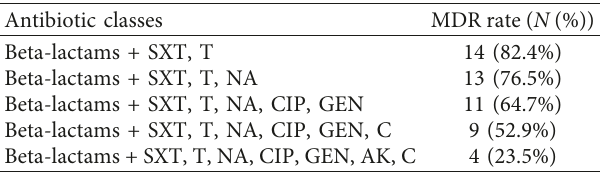
Table 5: Frequency of multidrug resistance pattern of ESBL- producing isolates from community-onset UTI patients in JUSH, Southwest of Ethiopia. Antibiotic